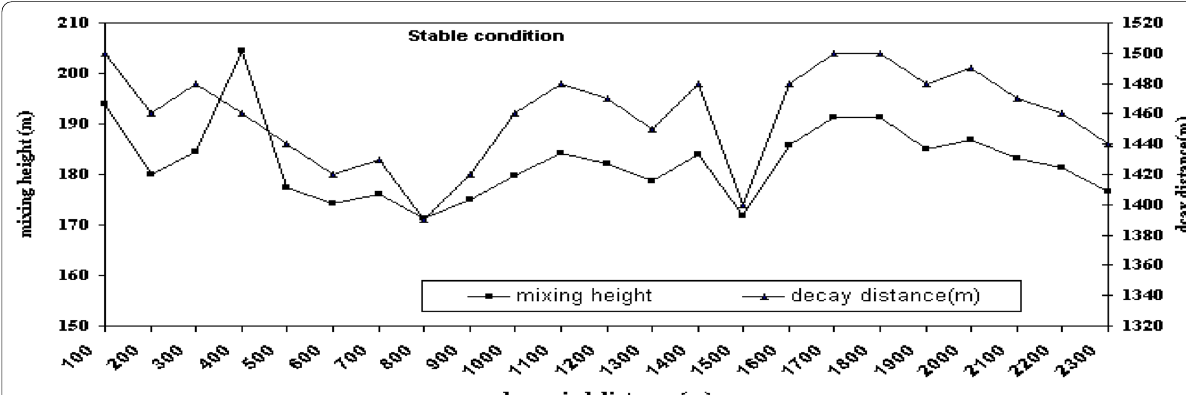
0.00E+002.00E-064.00E-066.00E-068.00E-061.00E-051.20E-051.40E-051.60E-051.80E-052.00E-05